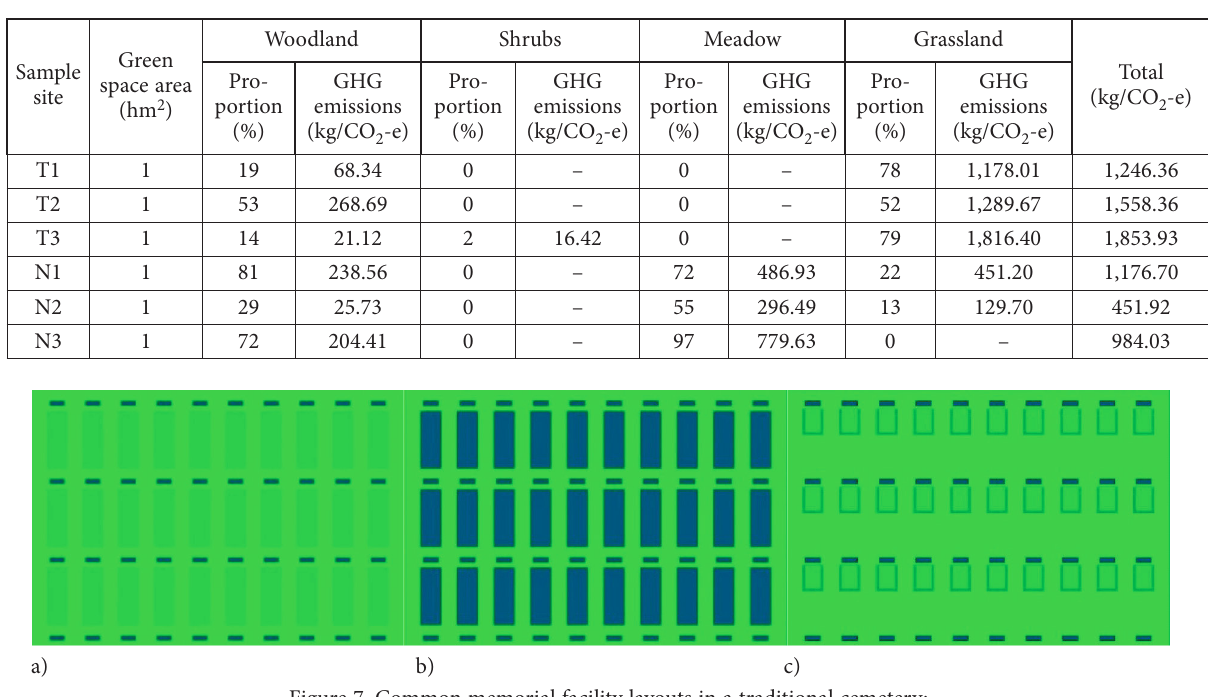
Table 6. GHG emissions of the various plant layers at the sample sites